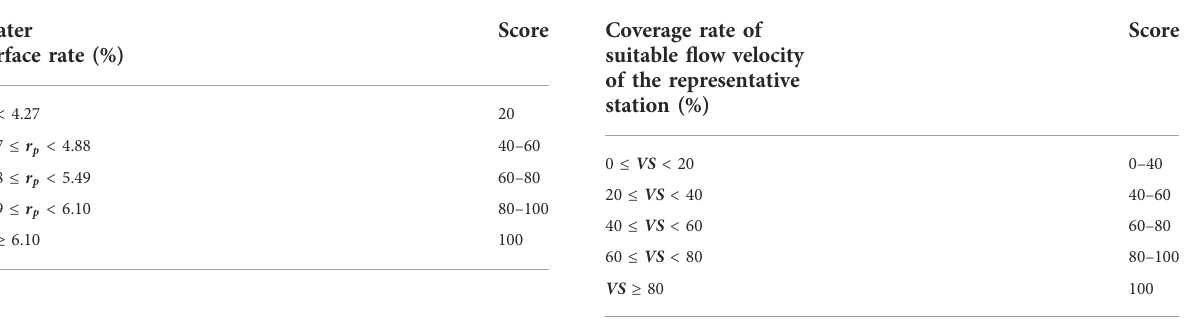
TABLE 2 Index evaluation criteria of the water surface rate. TABLE 3 Index evaluation criteria of VS